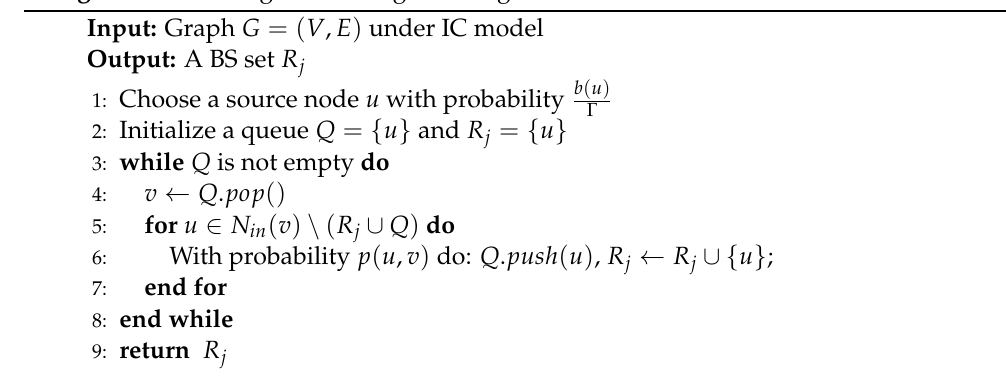
Algorithm 1: An algorithm for generating a BS under the IC